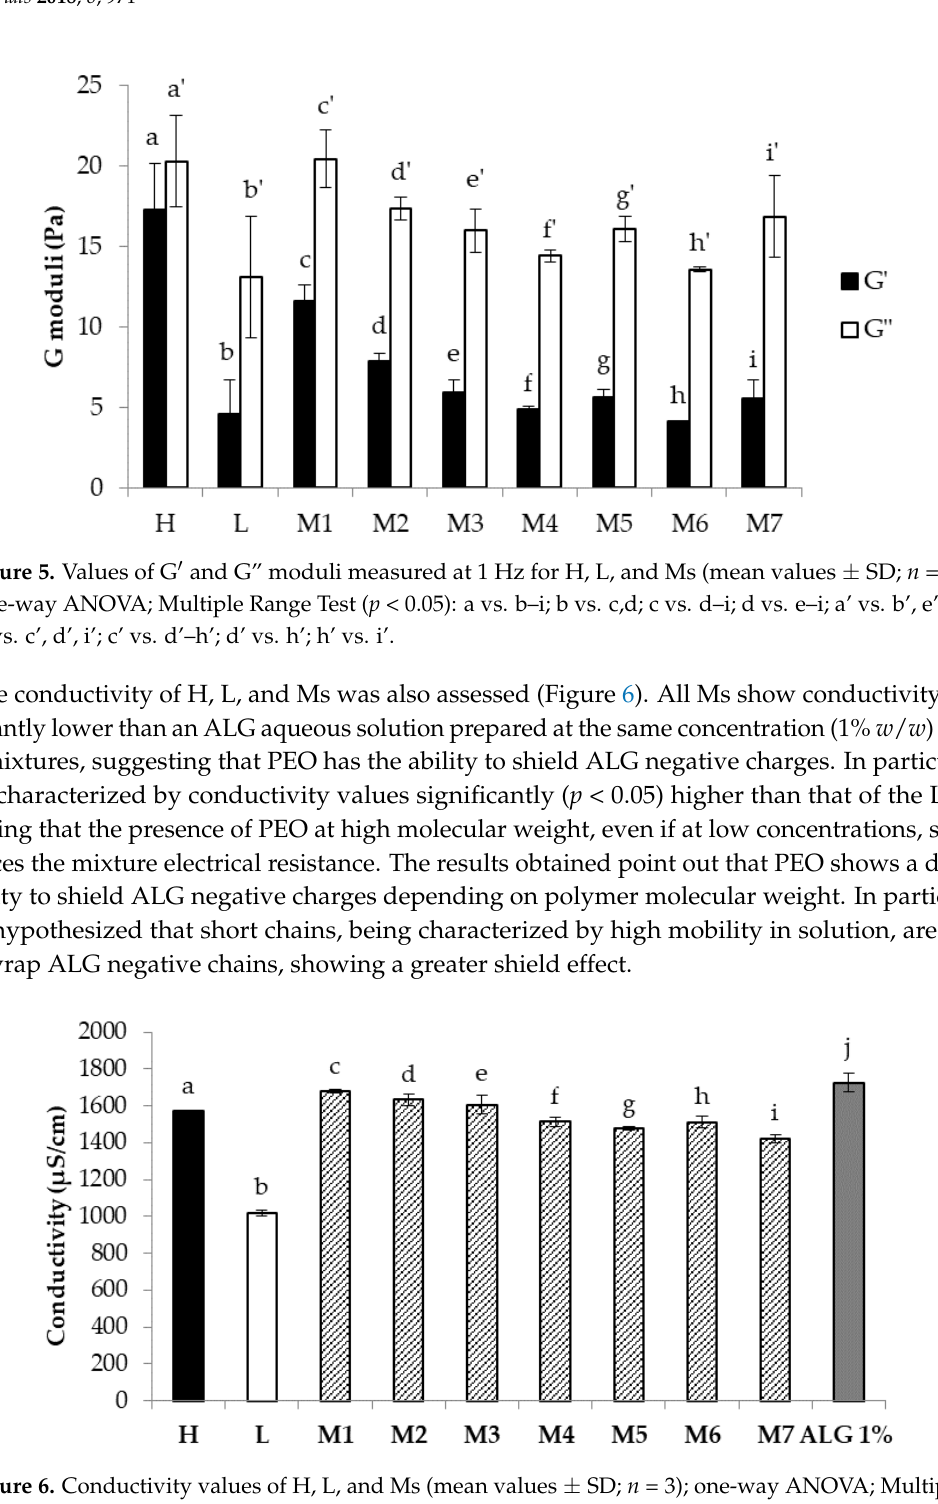
Figure 6. Conductivity values of H, L, and Ms (mean values ± SD; n = 3); one-way ANOVA; Multiple Range Test ( p < 0.05): a vs. b–d, f–j; b vs. c–j; c vs. d–j; d vs. f–j; e vs. f–j; f vs. g–j; g vs. h–j; h vs. j; i vs. j.